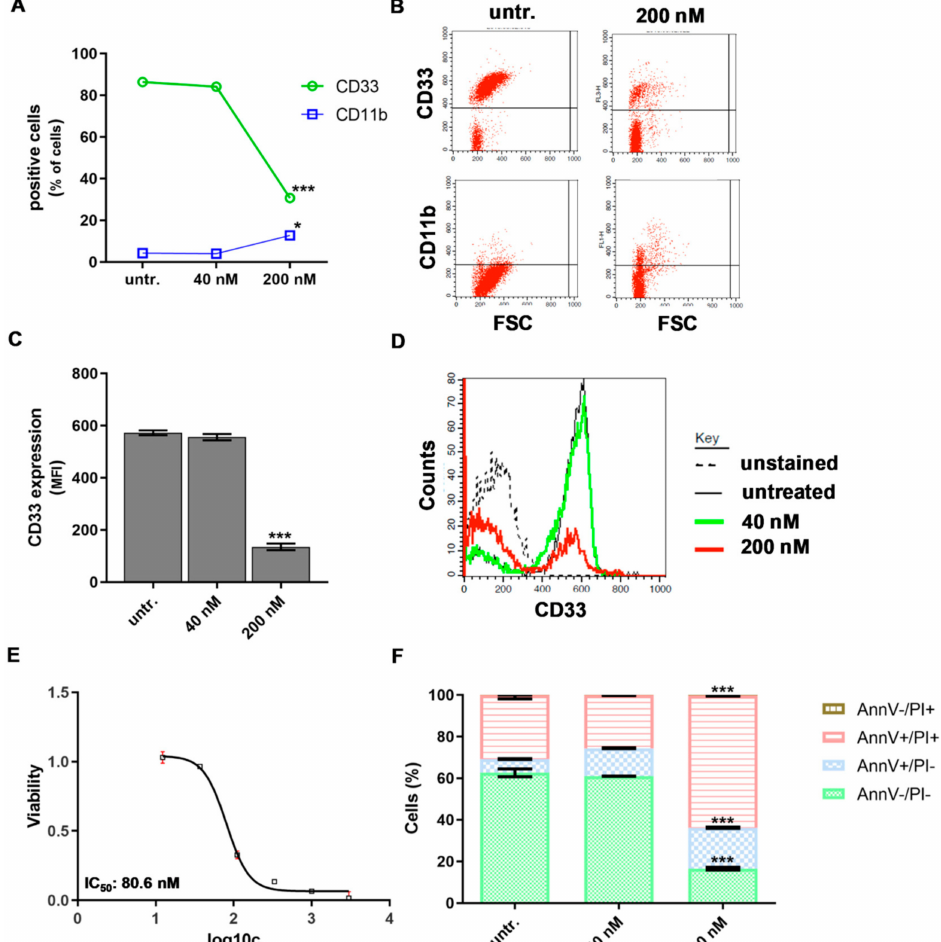
Figure 6. The human ‘AML1’ patient-derived bone marrow aspirate cells responded to DU325 with di ff erentiation-coupled apoptosis. The loss of the percentage of CD33 positive and an increase of CD11b positive cells were assayed by flow cytometry ( A ) and ( B ) after 48 incubation with 200 nM DU325. The median fluorescent intensity (MFI) proportional with CD33 expression on the cells also decreased by 200 nM DU325 ( C ) and ( D ). The resazurin viability assay determined IC 50 value of DU325 on the primary human patient-derived ‘AML1’ cells after 72 h treatment of 80.6 nM. Concentrations of DU325 were as follows, 3 µ M, 1 µ M, 333 nM, 111 nM, 37 nM, and 12 nM ( E ). The combined Annexin V and propidium iodide (AnnV / PI) flow cytometry staining showed an increase of both AnnV +/ PI- early and AnnV +/ PI + late apoptotic cells after treatment with 200 nM DU325 for 48 h ( F ). Data are shown as arithmetic mean values ± standard deviation. Statistical significance was set to *** p <